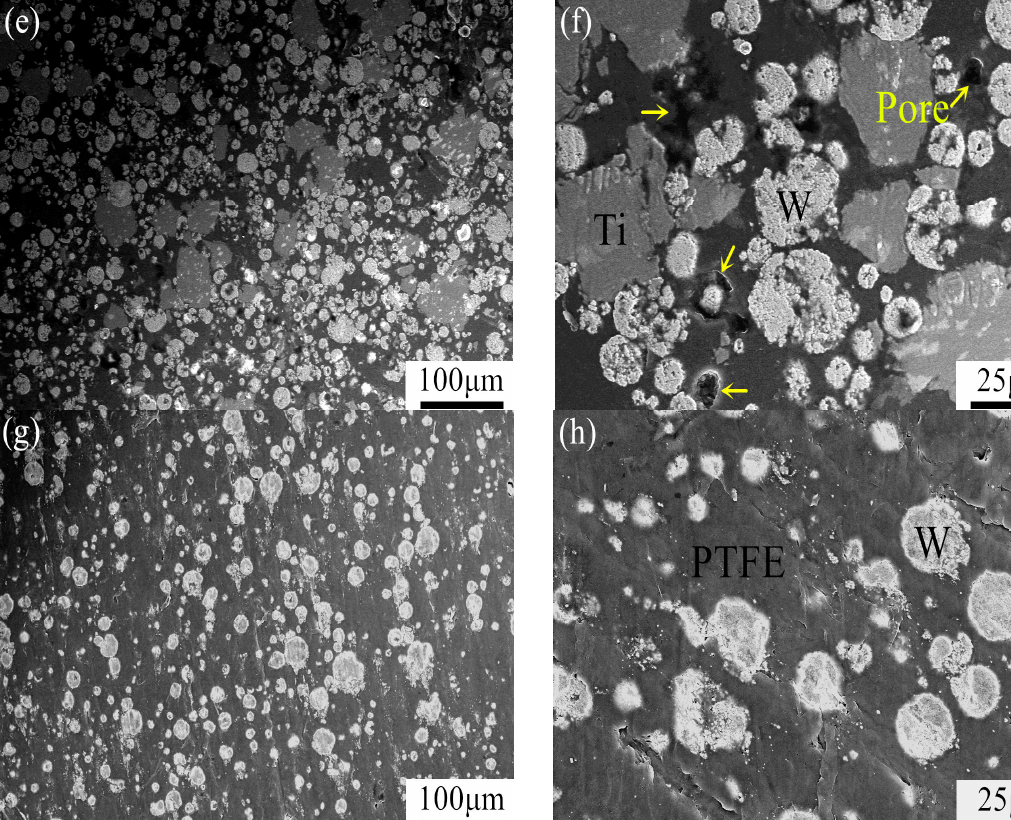
Figure 3. Backscattered scanning electron microscope (SEM) images of PTFE/Ti/W composites: ( a , b ) 98.8% TMD 68PTFE/32Ti; ( c , d ) 90.3% TMD 34PTFE/16Ti/50W; ( e , f ) 70.7% TMD 16PTFE/8Ti/76W; and ( g , h ) 96.7% TMD 45PTFE/55W.